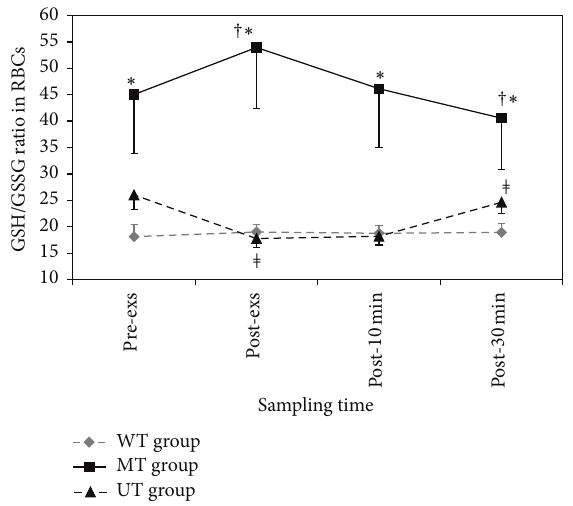
Figure 2: Effects of one session of aerobic exercise on plasma GSH/GSSG in subjects with different physical training status: values represent mean ± SEM. ∗ MT group versus WT and UT groups in basal ( 𝐹 = 6.666, 𝑝 = 0.004 ) and end point ( 𝐹 = 4.536, 𝑝 = 0.020 ) values. # ( 𝑝 < 0.001 ) WT group by time; † ( 𝑝 < 0.001 ) MT group by time; (cid:2) ( 𝑝 < 0.001 ) UT group by time.